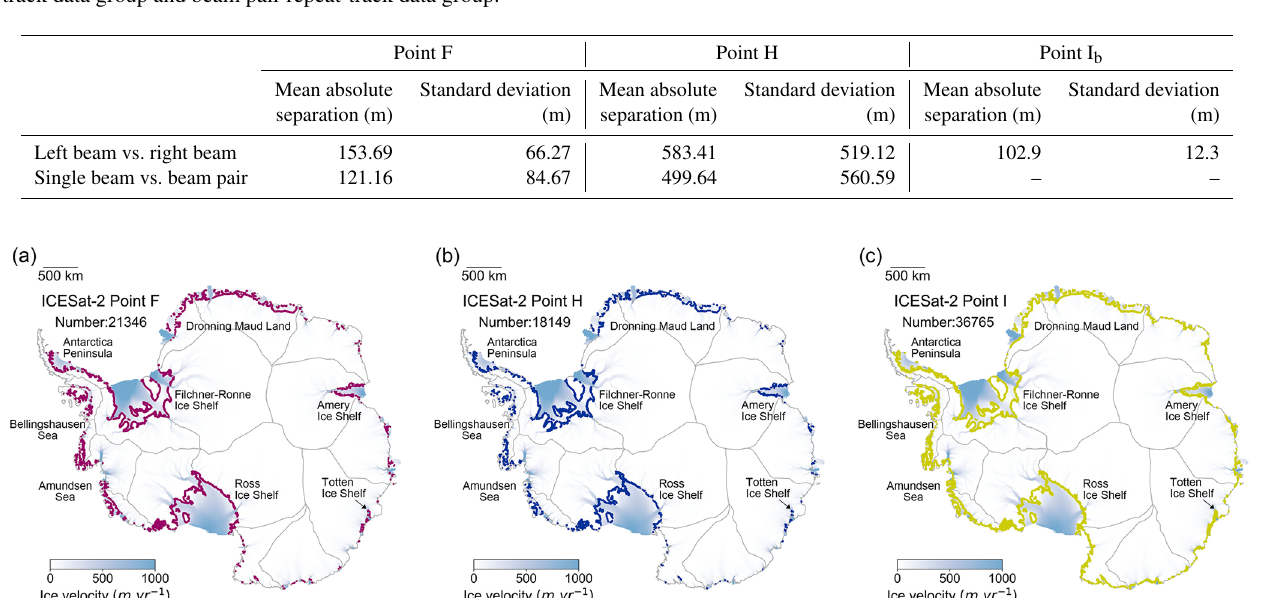
Table 1. Mean absolute separations and standard deviations between the grounding zone features calculated from the single-beam repeat- track data group and beam pair repeat-track data group.